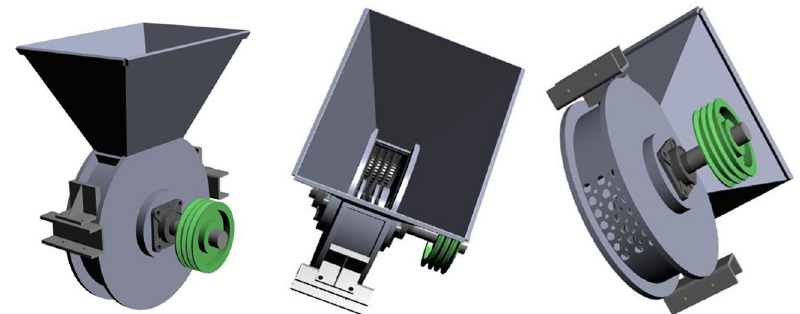
Figure 5. SolidWorks drawings of the grinding unit.